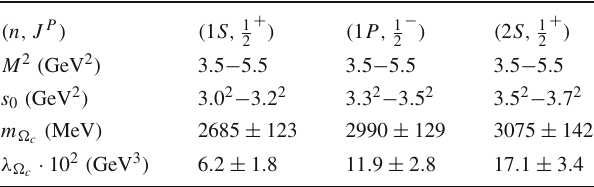
Table 1 The sum rule results for the masses and residues of the (cid:2) 0 c baryons with the spin-1 / 2